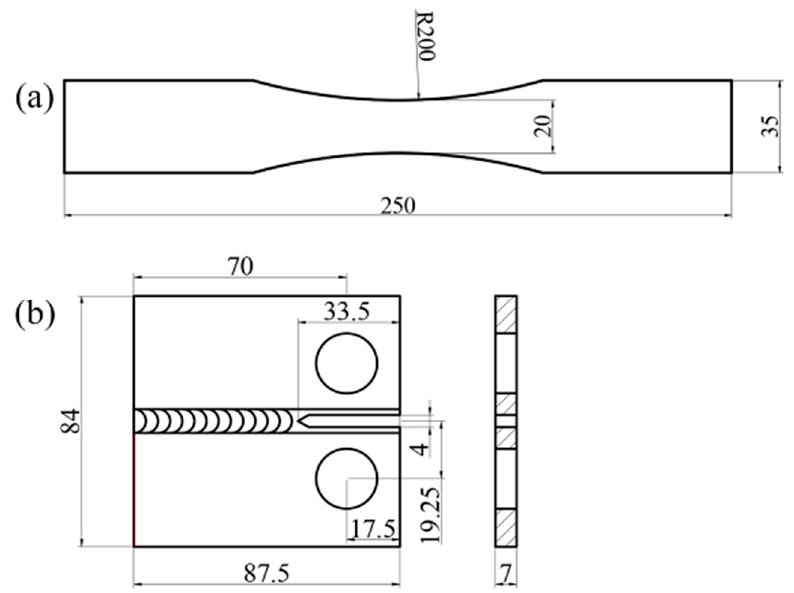
Figure 3. Geometry and main dimensions of fatigue testing specimens. ( a ) Smooth fatigue life specimen; ( b ) compact tension specimen. (unit: mm)